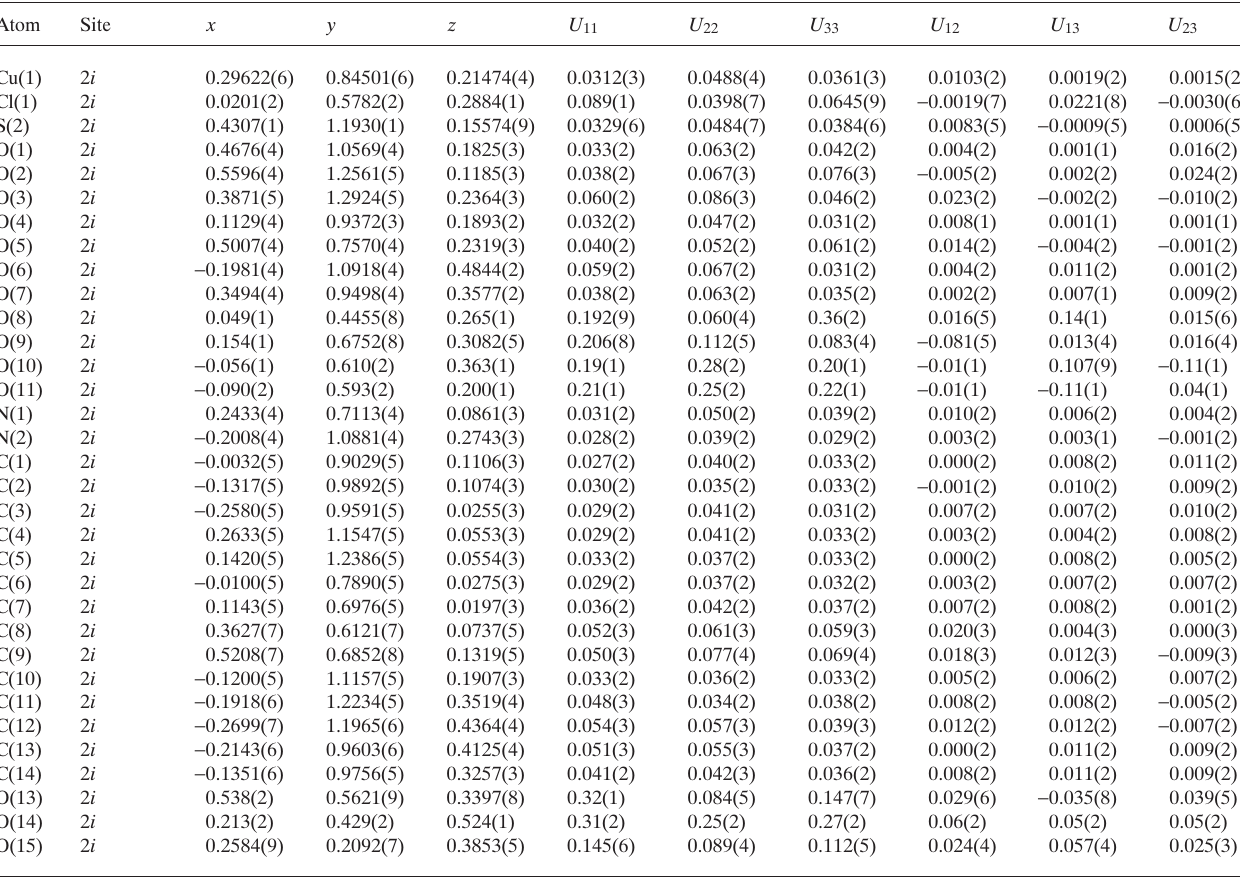
Table 3. Atomic coordinates and displacement parameters (in Å 2 ) .